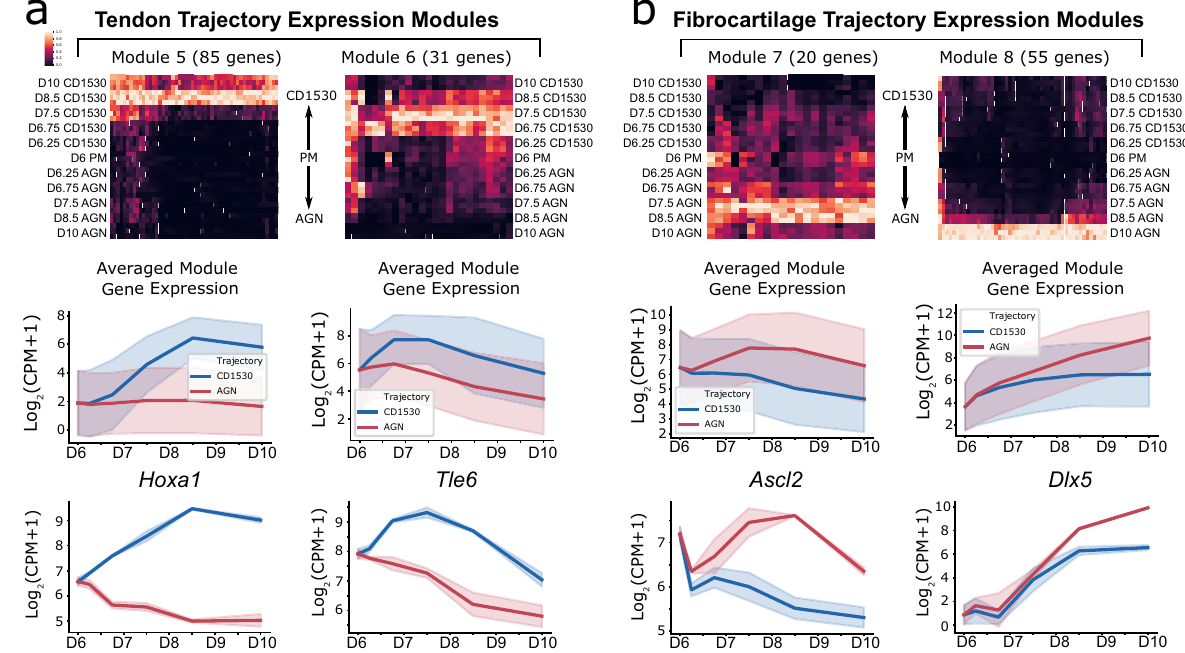
Fig. 5 Transcriptional pro fi ling and trajectory analysis by RNA sequencing reveals transcription factor modules associated with fate-speci fi c tendon and fi brocartilage induction. Fate-dependent gene modules for ( a ) tendon and ( b ) fi brocartilage trajectories represented as column-normalized heatmaps, averaged module gene expression line plots, and representative transcription factors. ( n = 3 independent samples). Standard deviation is represented by shaded fi brocartilage AGN 193109-containing media was suf fi cient to maintain the phenotype of the cells, maintenance of the tenogenic phenotype may require additional cues.